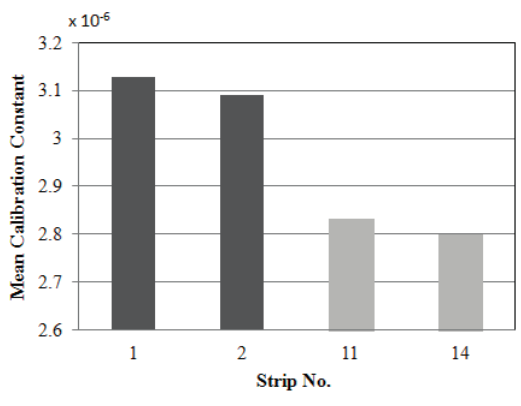
Figure 6. Comparison of calibration constants.